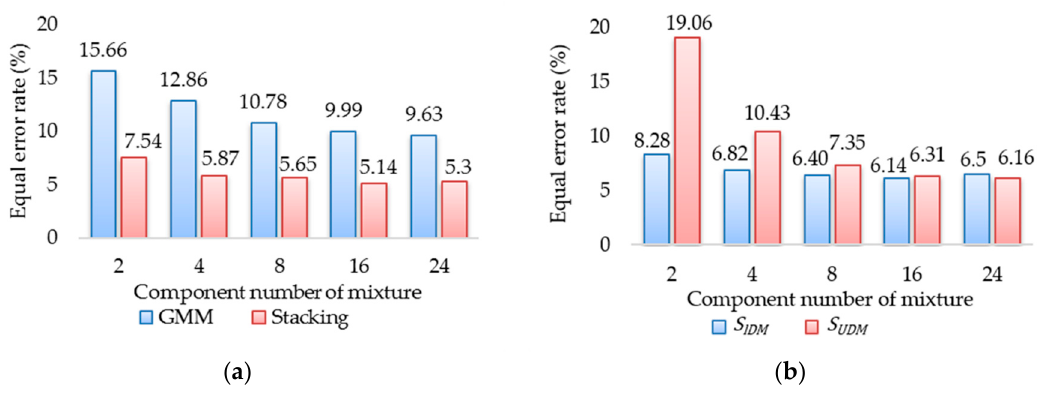
Figure 9. Equal error rate (EER) with respect to various numbers of Gaussian components: ( a ) GMM and Stacking; ( b ) two base SVMs S IDM and S UDM Table 2. Average training time with respect to the number of Gaussian components.